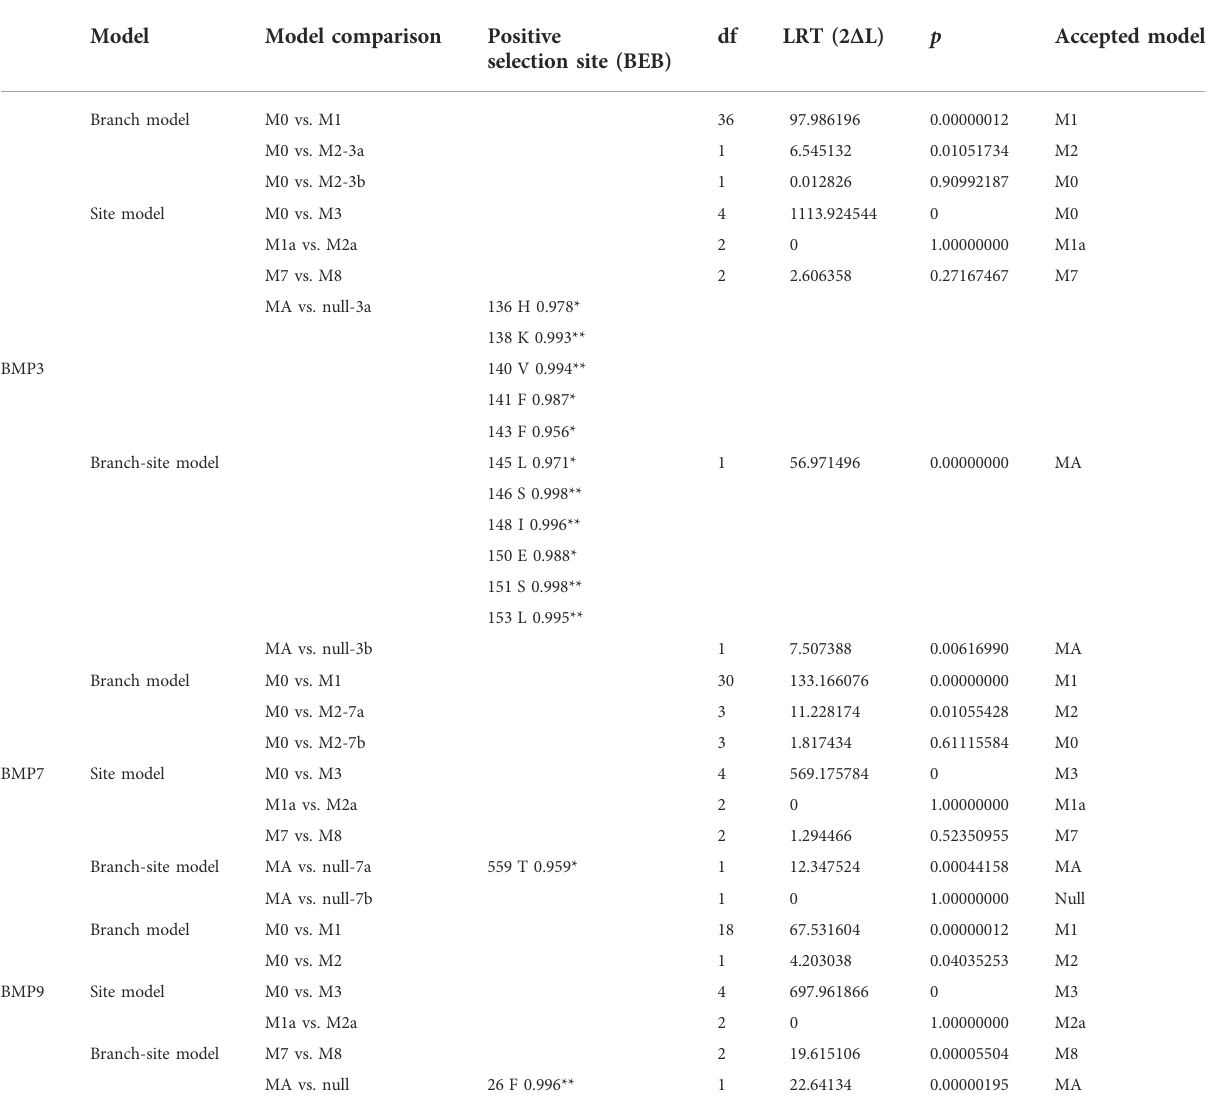
TABLE 3 Likelihood ratio test statistics for BMP3, BMP7 and